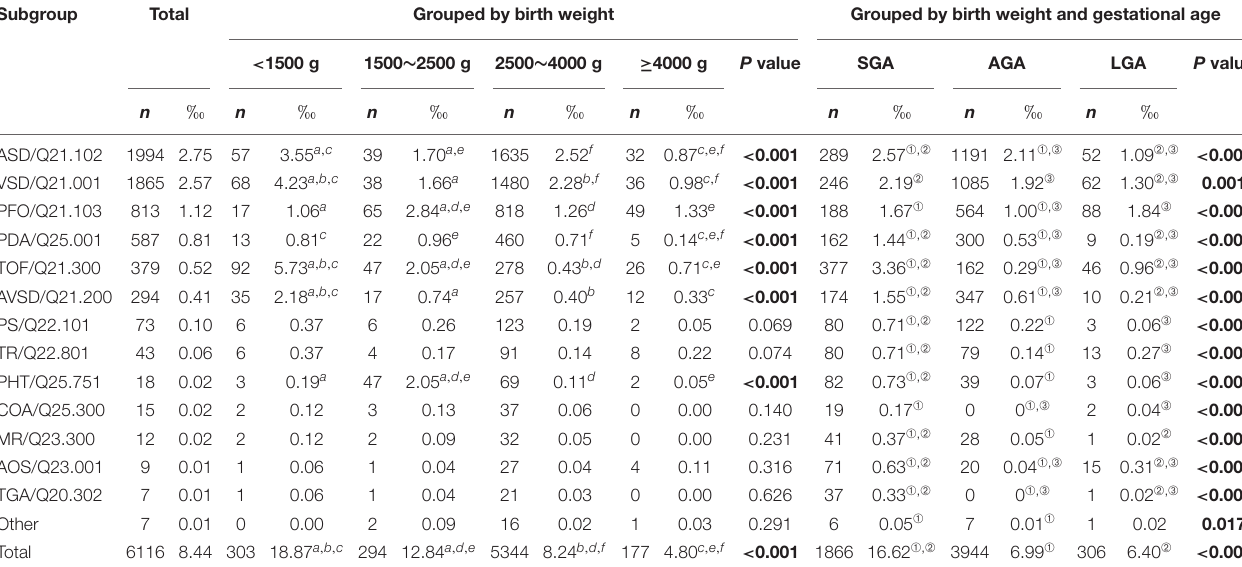
TABLE 1 | Prevalence of different subtypes of congenital heart disease by birth weight (average prevalence from 2014 to 2020). Subgroup Total Grouped by birth weight Grouped by birth weight and gestational age